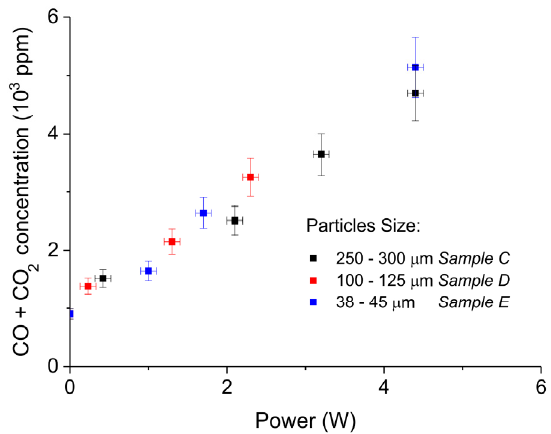
Figure 8. Sum of CO 2 and CO concentrations as function of power during decomposition of CaCO 3 samples with different particles size (samples C, D, and E); all the experiments were performed at 630 °C, in pure argon, and at a flow rate 30 mL/min.